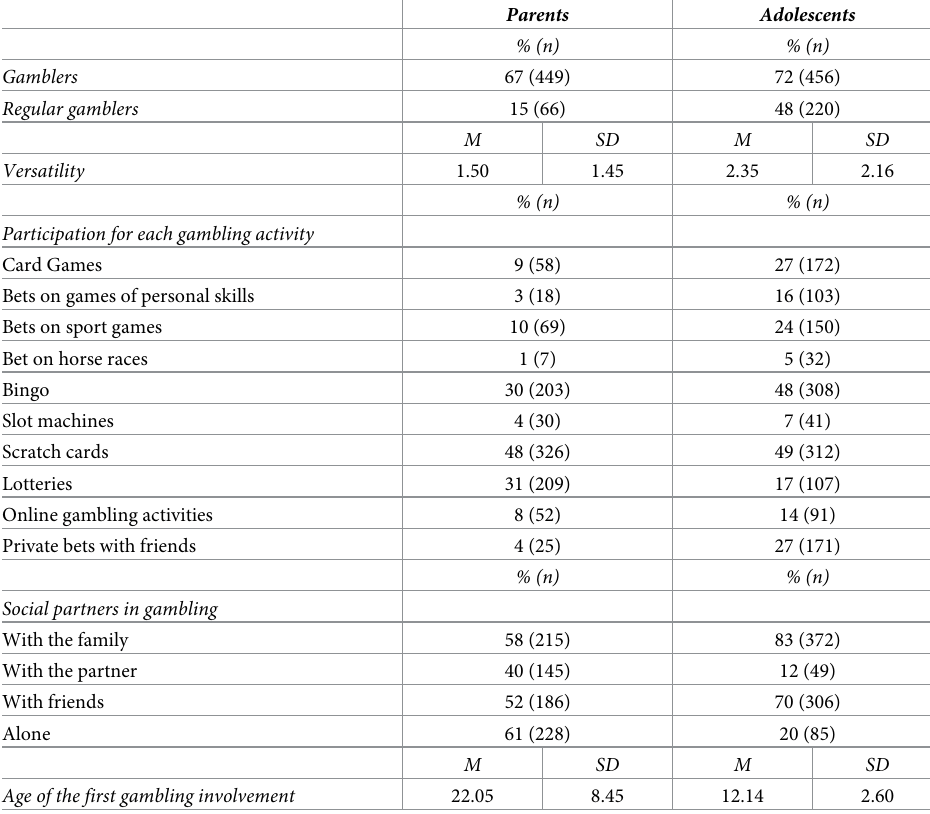
Table 1. Gambling behavior features among adolescents and their parents (n =